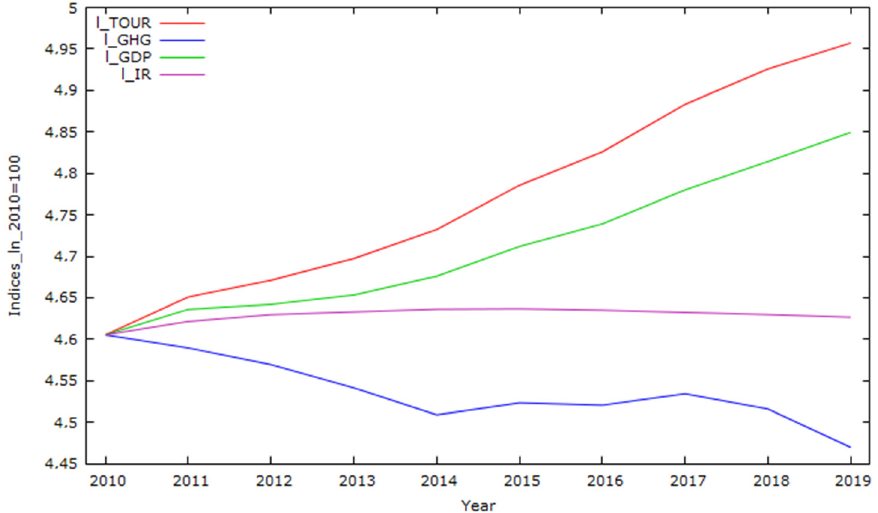
Figure A1. Evolution of factors for sustainability and economic growth. Note: GDP—gross domestic product, GHG—air emissions accounting for greenhouse gases, TOUR—tourist arrivals, IR—6-month interest rate, and ln—natural logarithm. Source: Authors’ compilation based on Eurostat (2022) data.